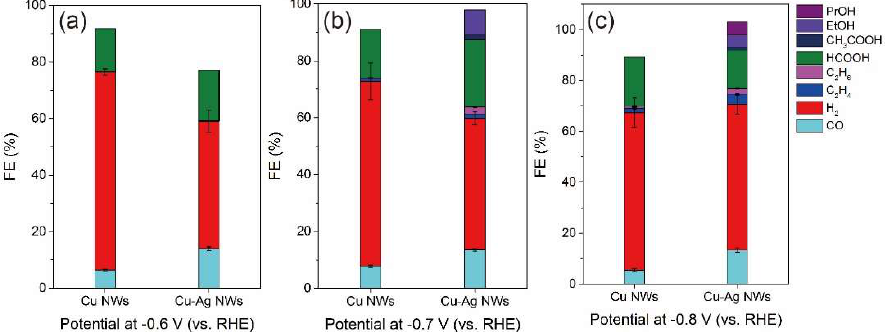
Figure 6. Faradaic efficiency (FE) of the major products for the Cu NWs and the Cu–Ag NWs at different applied potentials: − 0.6 V ( a ), − 0.7 V ( b ) and − 0.8 V ( c ).